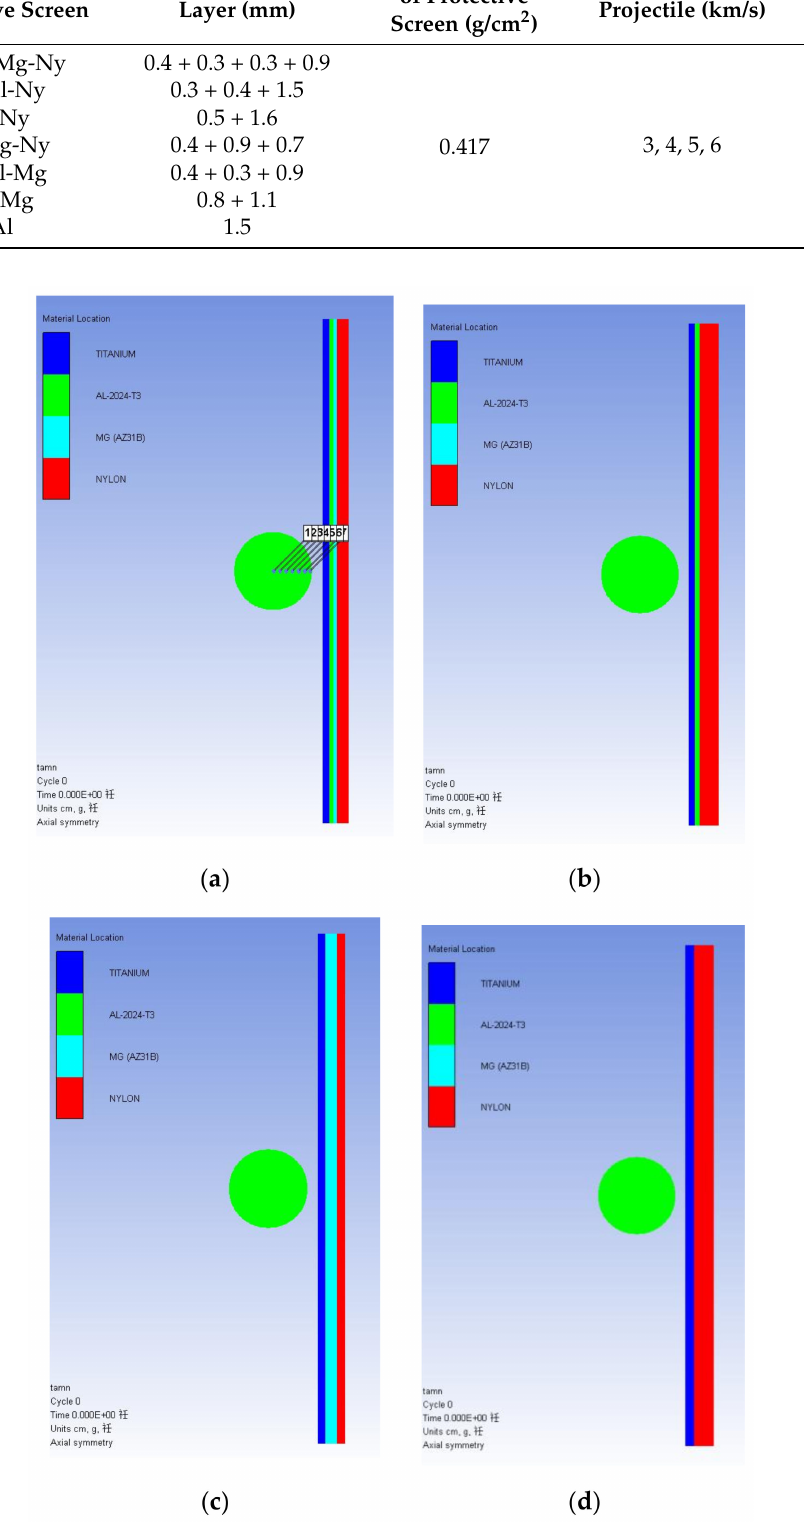
Figure 4. Calculation model for working conditions 1–4: ( a ) Ti-Al-Mg-Ny protective screen; ( b ) Ti-Al-Ny protective screen; ( c ) Ti-Mg-Ny protective screen; ( d ) Ti-Ny protective